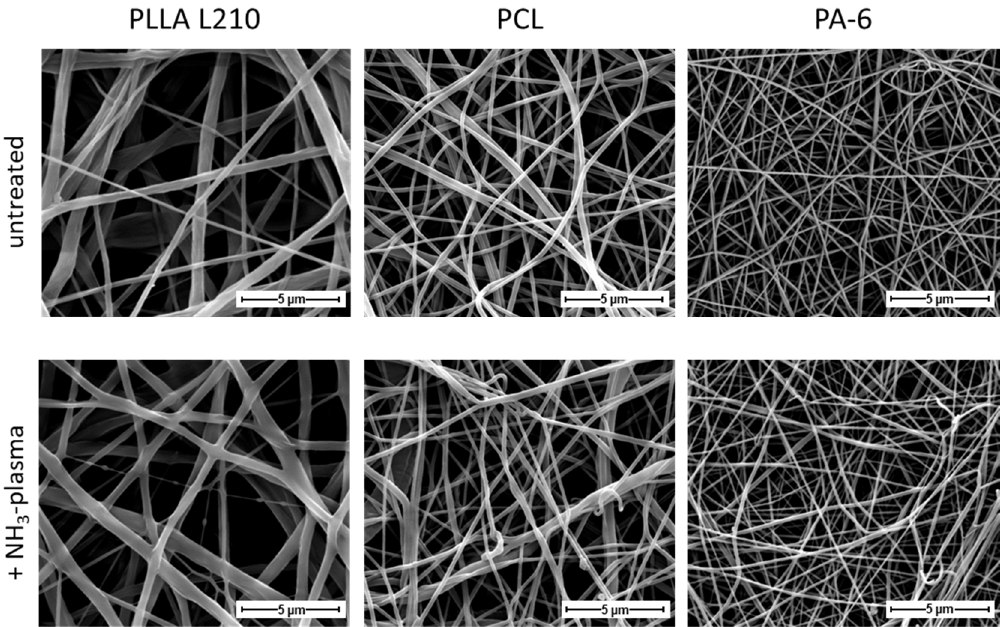
Figure 3. High-resolution scanning electron micrographs of morphology of untreated ( first row ) and NH 3 -plasma treated ( second row ) nanofibrous PLLA L210, PCL and PA-6 nonwovens (magni- fication ×8000, bar = 5 µm).